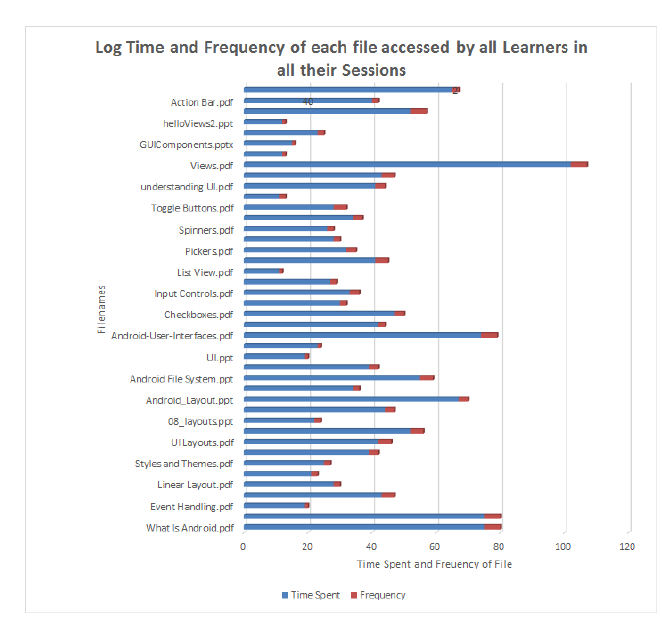
Figure 2. Frequency and Time Spent on Specific File by Learners